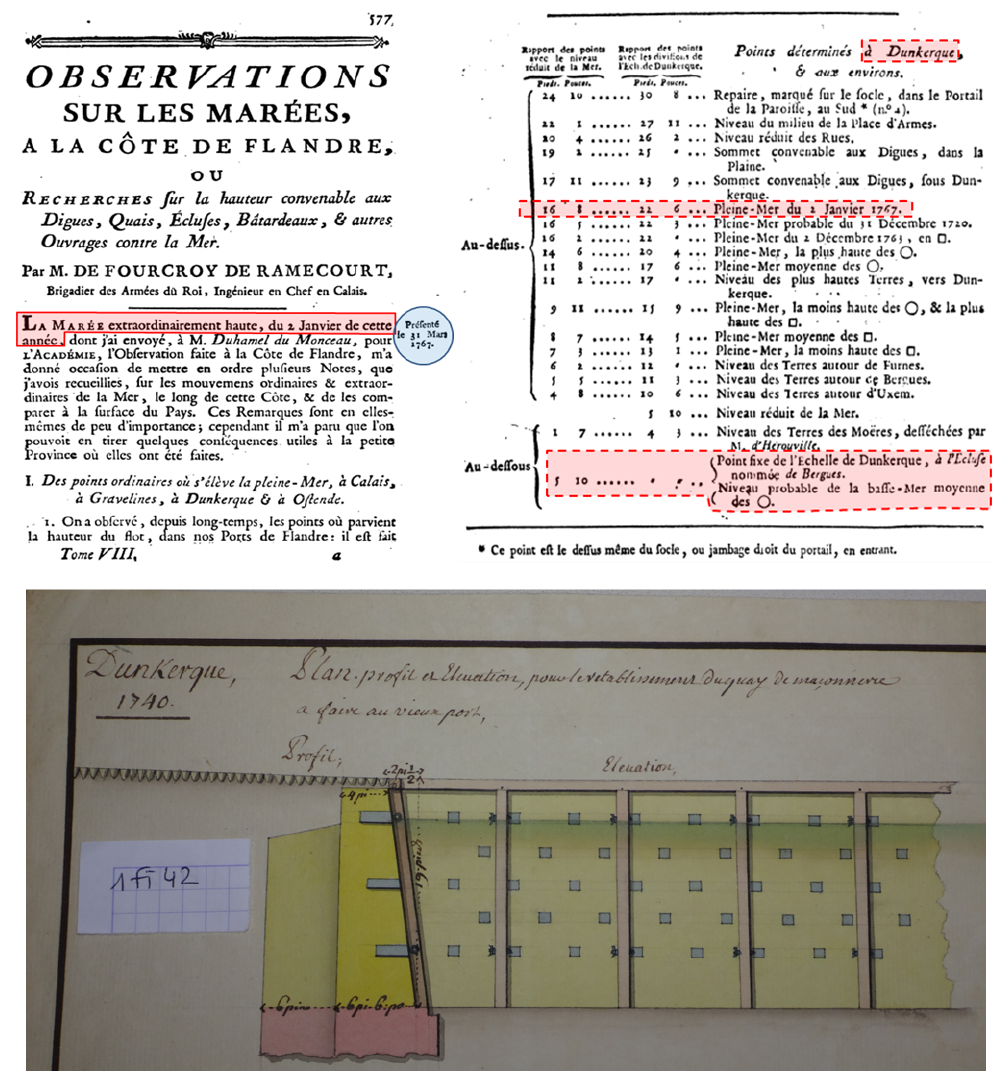
Figure 3. Two examples of HI as presented in the archives. Top panel: the 1767 extreme storm surge event in Dunkirk (De Fourcroy de Ramecourt, 1780); bottom panel: a profile of the Dunkirk harbor dock from the municipal archives of Dunkirk (ref. 1Fi42, 1740). Translation of the text highlighted in red is as follows: surcote de Pleine mer: skew surge; La marée extraordinairement haute, du 2 janvier de cette année: the tide was extraordinarily high this year on 2 January; Point fixe de l’Echelle de Dunkerque: fixed point of the Dunkirk scale; Niveau probable de la basse-Mer moyenne: probable level of the mean low